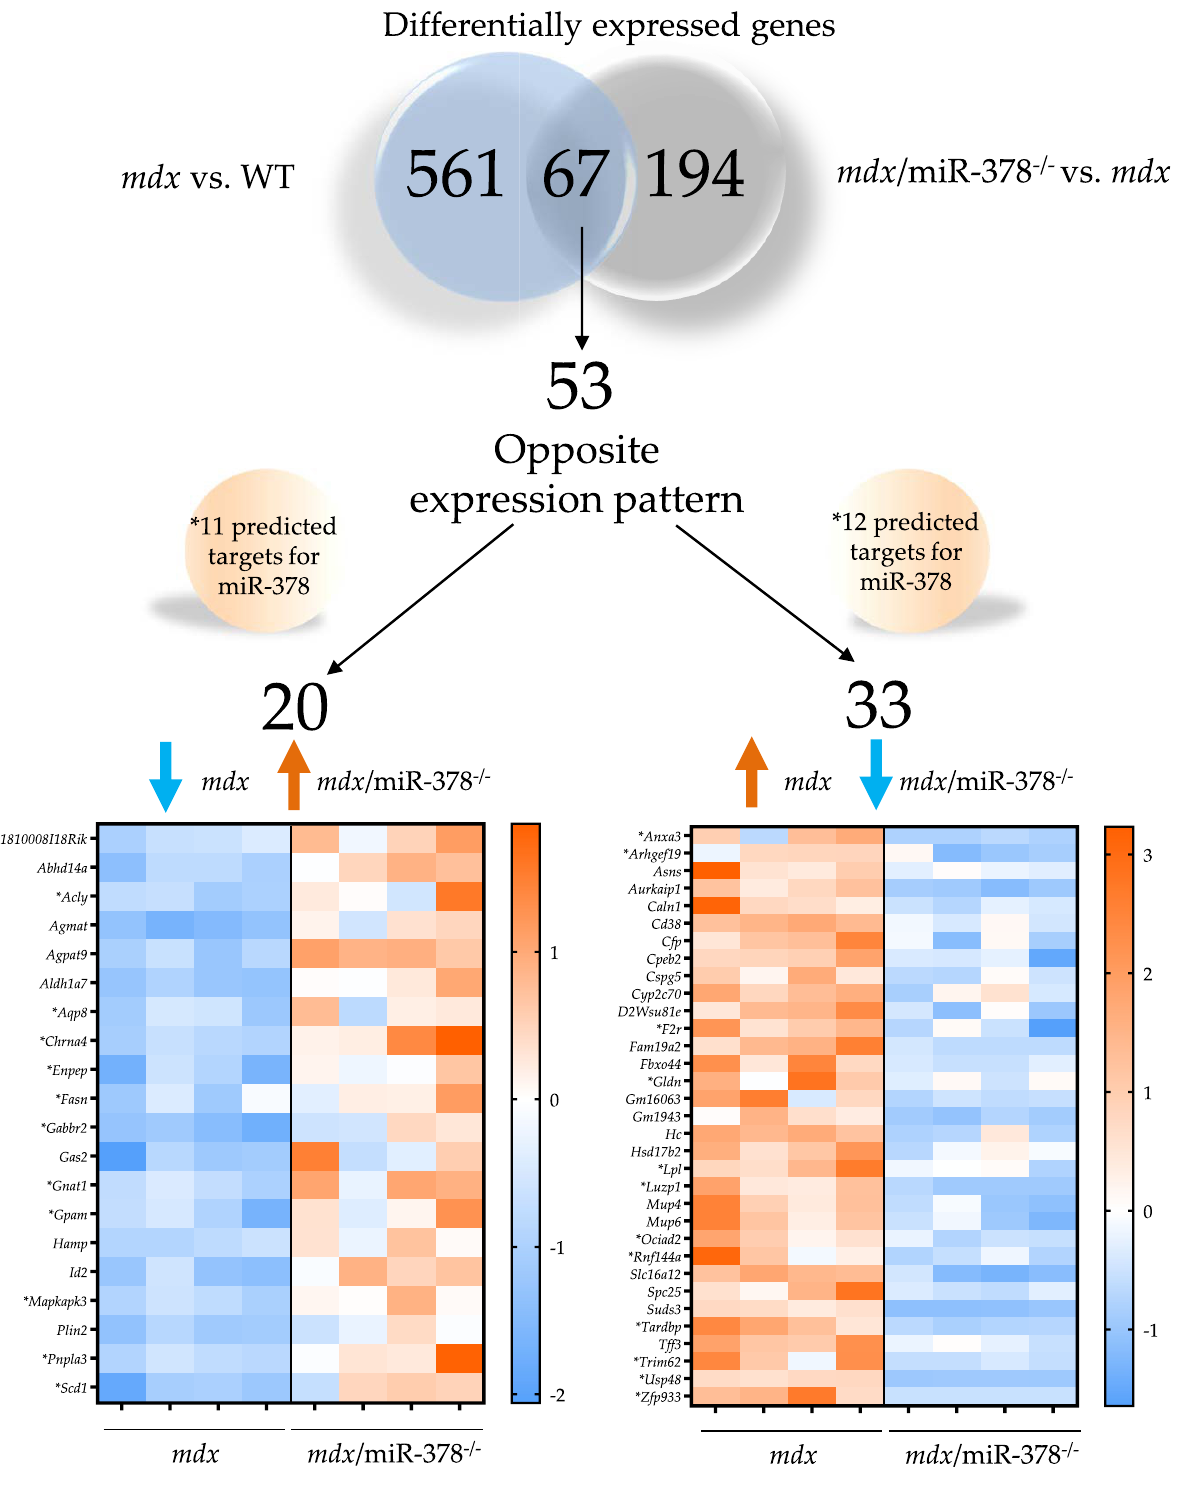
Figure 7. The analysis of oppositely expressed genes in the liver of the mdx vs. WT and mdx /miR-378 −/− vs. mdx mice. Based on RNA-seq analysis, 67 genes were found to be differentially expressed in both comparisons. 53 of them exhibited opposite expression patterns: 20 genes were downregulated in mdx and upregulated in mdx /miR-378 −/− livers, whereas 33 were elevated in mdx and downregulated in mdx /miR-378 −/− livers. The expression pattern and gene names are presented on heat maps. Orange color indicates upregulation whereas blue color downregulation. Asterisks indicate genes predicted to be miR-378 targets according to the miRmap